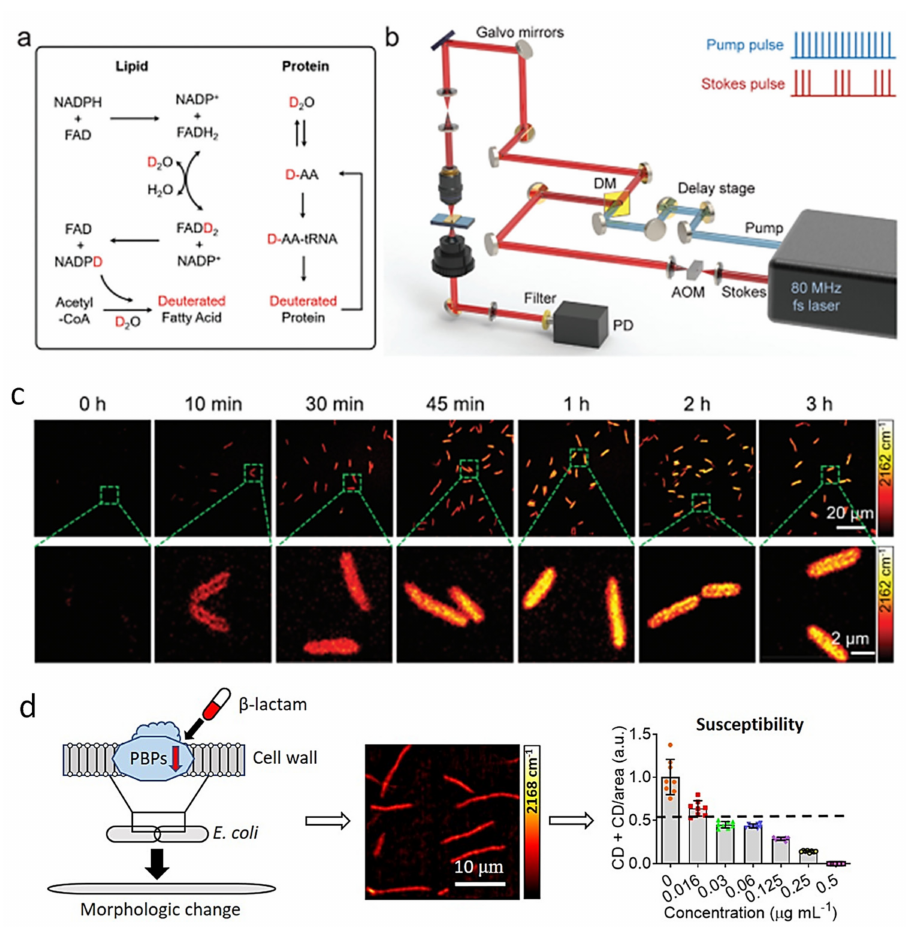
Figure 8. SRS imaging of D 2 O metabolic incorporation for rapid AST. ( a ) Scheme for D 2 O labeling of lipid and protein. ( b ) SRS imaging setup. ( c ) Time-lapse SRS imaging of P . aeruginosa after culture in D 2 O-containing medium. ( d ) A new evaluation method by SRS metabolic imaging and morphological deformation of E . coli that treated with a β -lactam antibiotic for rapid AST. Penicillin-binding proteins (PBPs). Reprinted from reference [22,89] with